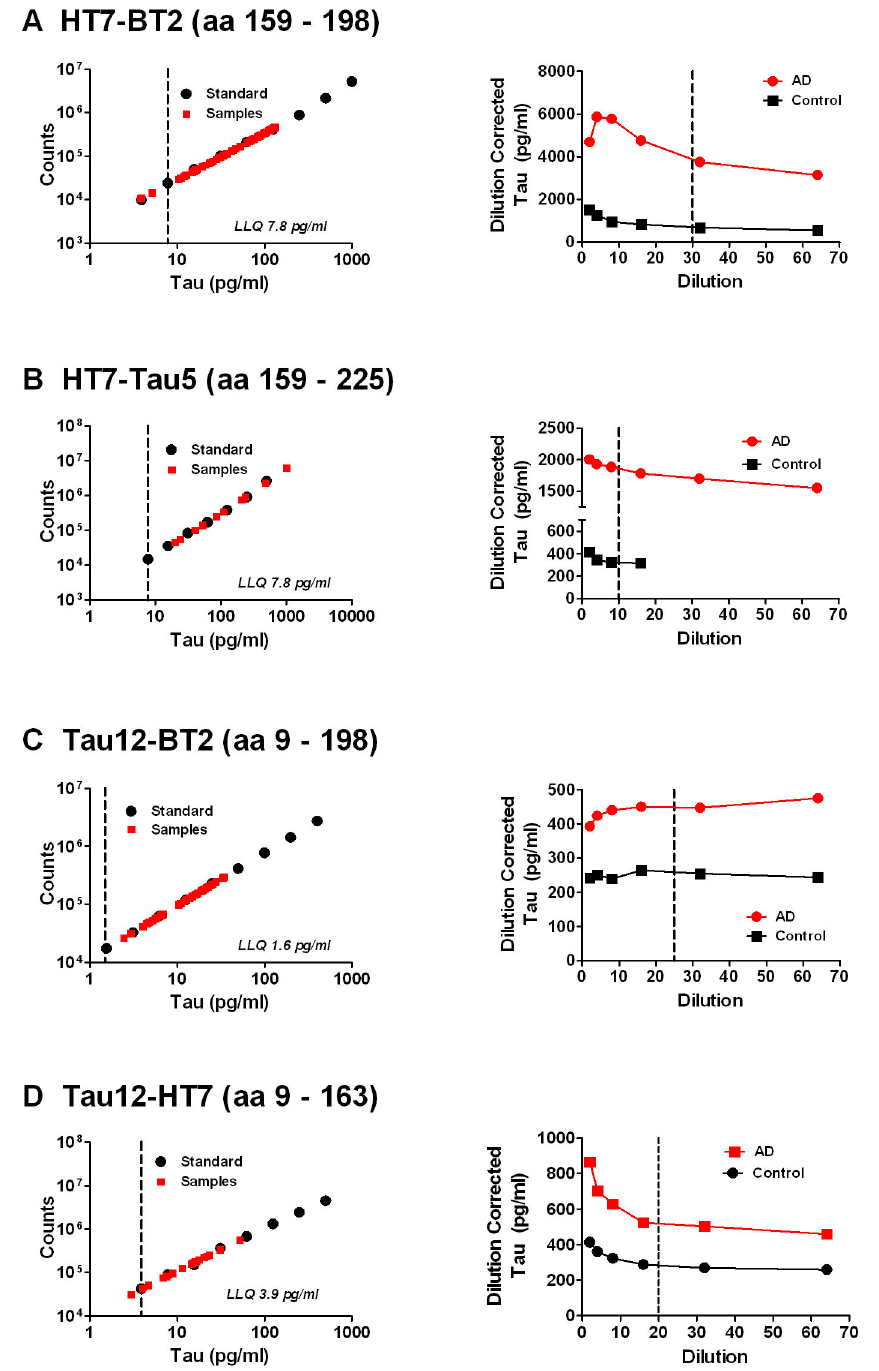
Figure 3. Characterization of tau ELISAs. Representative tau 441 standard curves (left panels) and CSF dilution linearity results (right panels) shown for A) HT7-BT2, B) HT7-Tau5, C) Tau12-BT2 and D) Tau12-HT7 tau ELISAs. On each standard curve graph, tau 441 calibrators (Standards) and results for CSF sample dilutions (Samples) are shown. The assay lower limit of quantitation (LLQ, vertical dashed line) is also indicated. On each dilution linearity graph, dilution-corrected tau levels for a pooled control CSF sample and a pooled AD CSF sample relative to sample dilution are shown. The vertical dashed lines indicate the dilution determined to be optimal for CSF analysis.